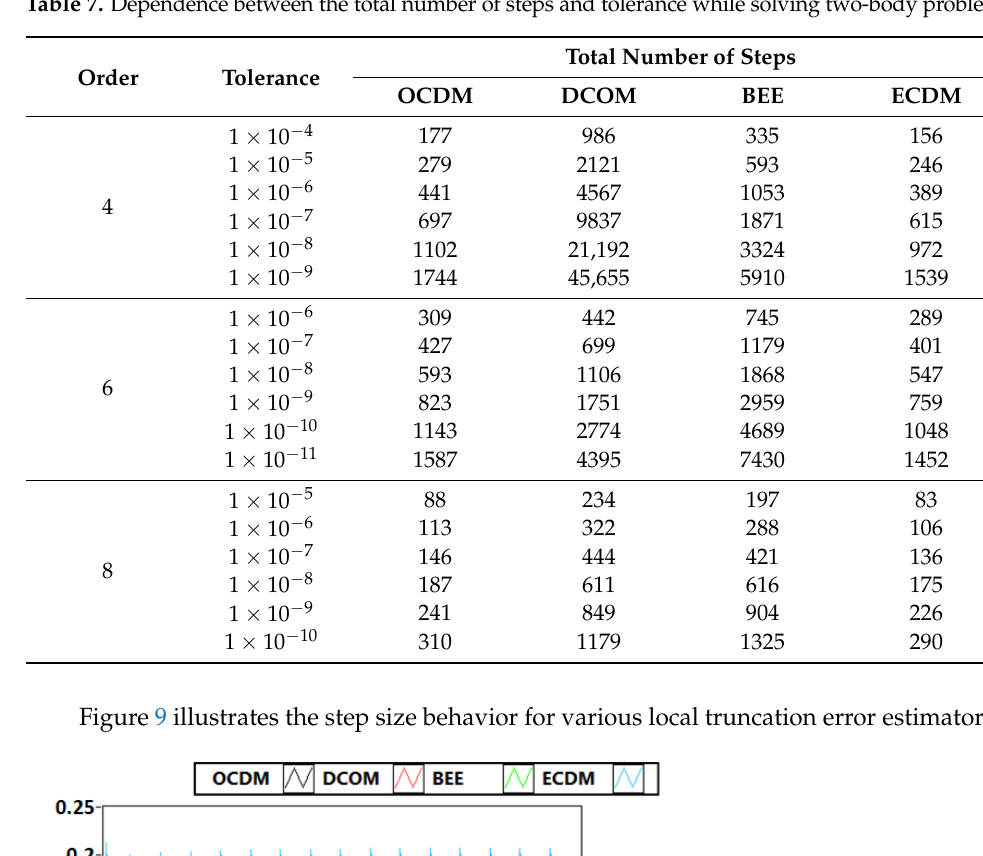
Table 7. Dependence between the total number of steps and tolerance while solving two-body problem.